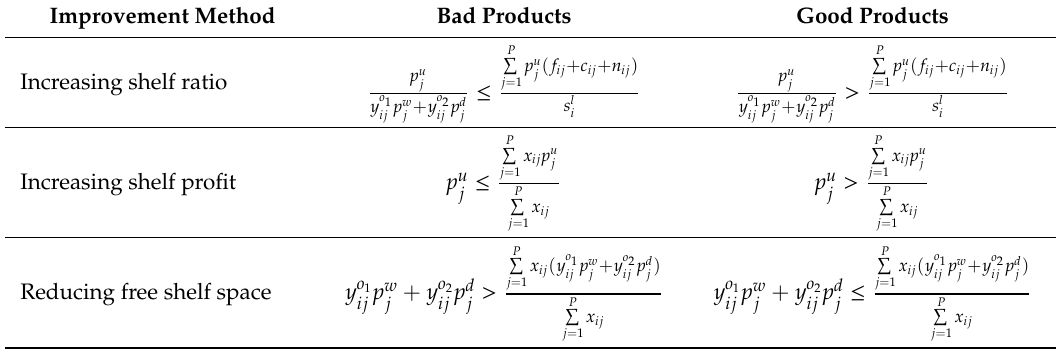
Table 1. Formulations for bad and good products in the proposed improvement